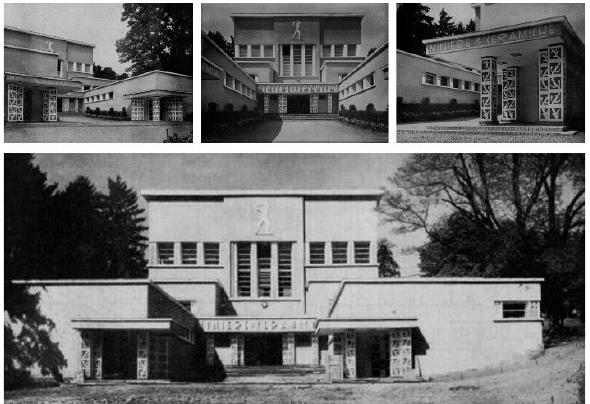
Figure 4. Old photos of “Mines and Ceramics” pavilion. In: Pagano et al., 1930